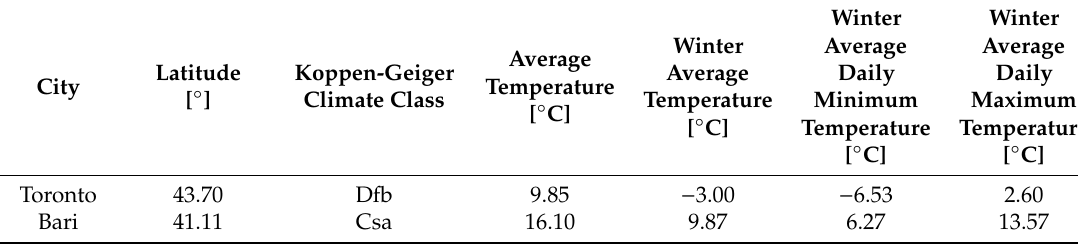
Table 2. Climate characteristics of the two locations considered in this